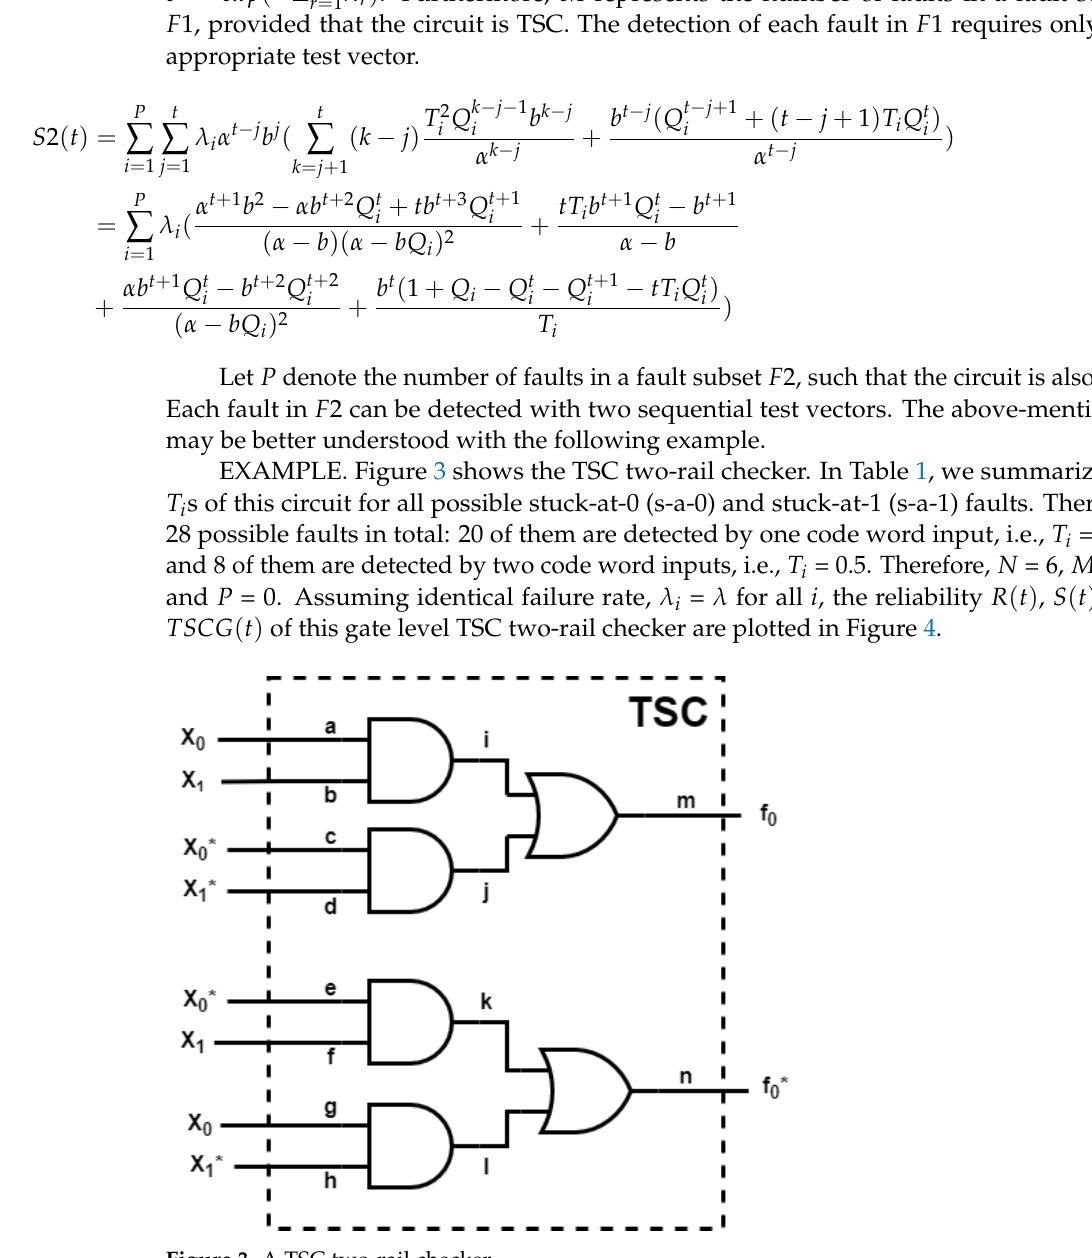
Figure 3. A TSC two-rail